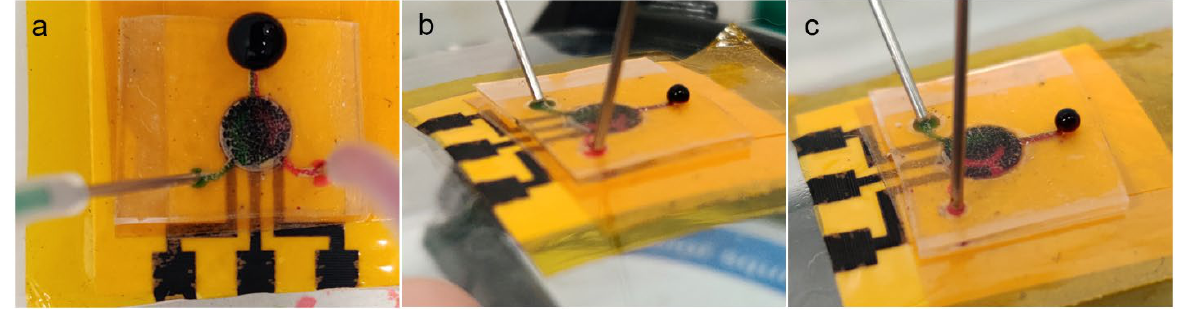
Figure 8. Photographs showing microfluidic flow testing of an assembled flexible microfluidic sensing device with a flow speed of 20 µL/min under different surfaces: ( a ) flat surface, ( b ) curved surface (safety goggle lens) and ( c ) body of a 500-mL laboratory glass bottle.